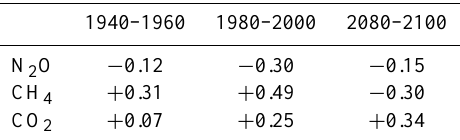
Table 4. Percentage change in annual/global average total ozone for the compounds and time intervals listed, based on the sensitivity factors in Table 3 and the change in the surface boundary condition in the A1B scenario (Fig. 1). The CH 4 -induced ozone change is negative for 2080–2100 due to the decrease in the methane bound- ary condition during this